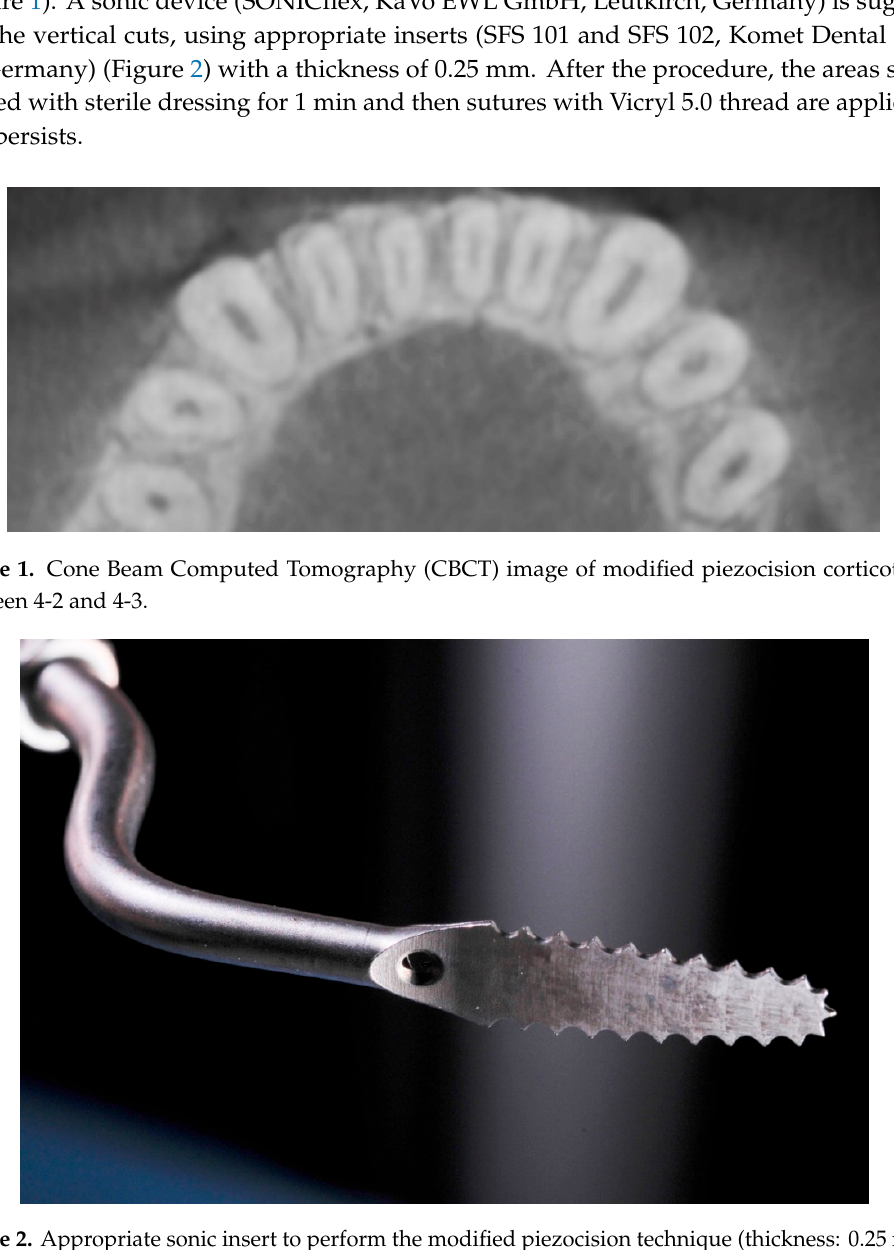
Figure 2. Appropriate sonic insert to perform the modified piezocision technique (thickness: 0.25 mm).